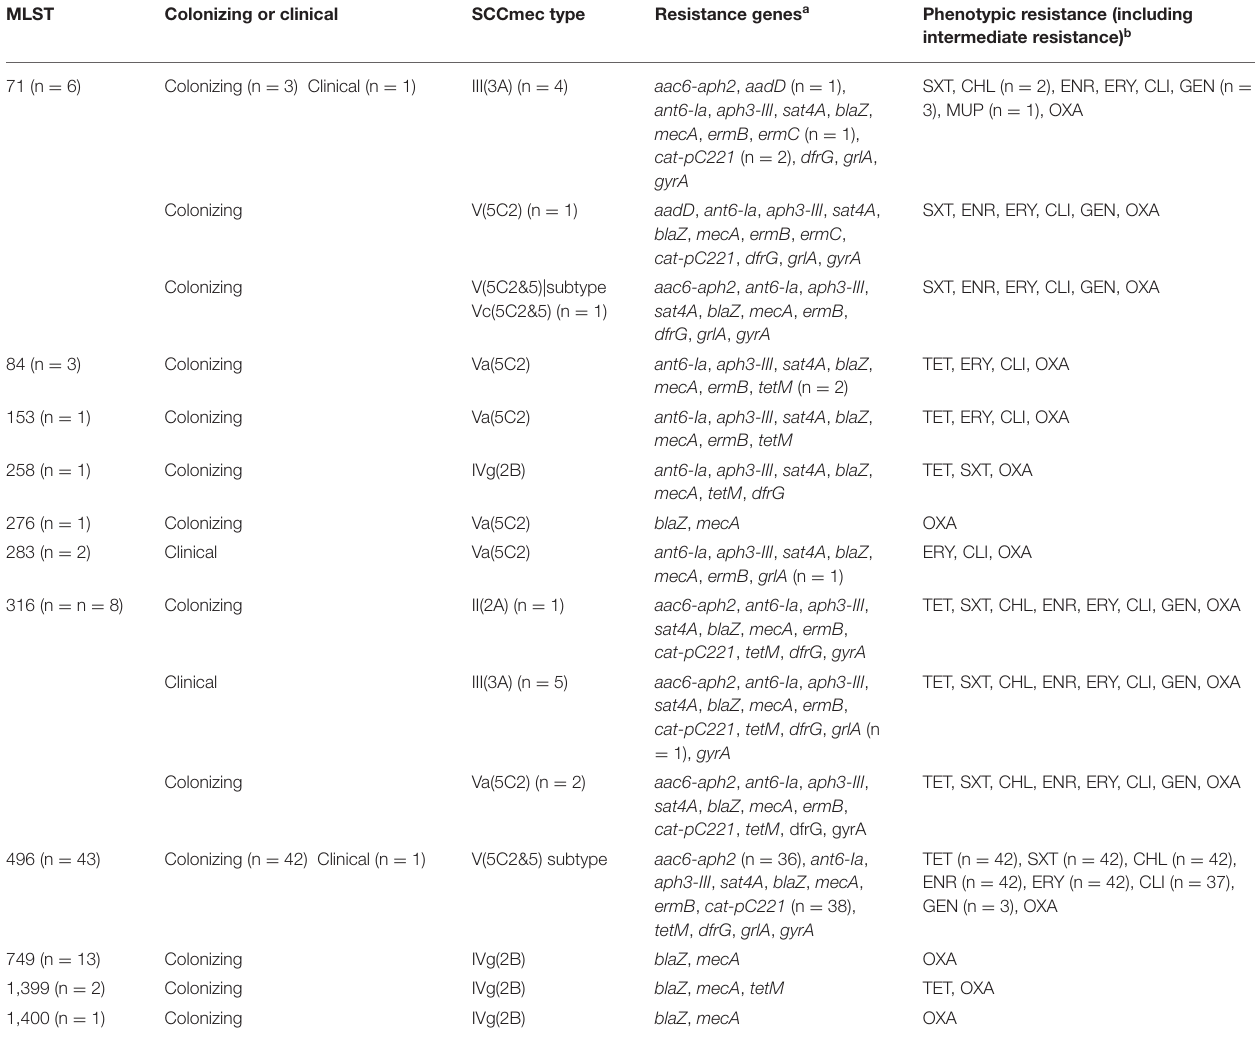
TABLE 2 | The molecular characteristics of both clinical and colonizing methicillin-resistant Staphylococcus pseudintermedius . MLST Colonizing or clinical SCCmec type Resistance genes